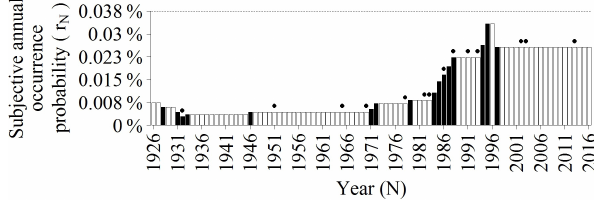
Figure 6. Estimated subjective annual occurrence probability be- tween 1927 and 2016. The horizontal dashed line corresponds to the historical average value. Black bars represent the significant evolutions and dots indicate the occurrence of the following big earthquakes in California: 1933 Long Beach, 1952 Kern County, 1966 Parkfield, 1971 San Fernando, 1979 Coyote Lake, 1979 Im- perial Valley and Coyote Lake, 1983 Coalinga, 1984 Morgan Hill, 1987 Whittier Narrows, 1989 Loma Prieta, 1992 Big Bear and Landers, 1994 Northridge, 2003 San Simeon, 2004 Parkfield and 2014